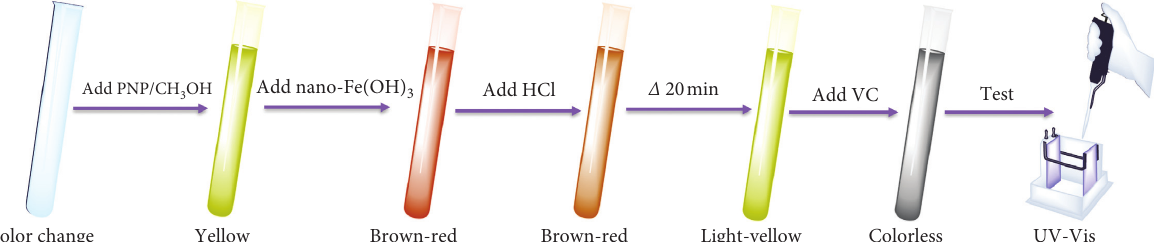
Figure 3: Experimental procedures and phenomena.